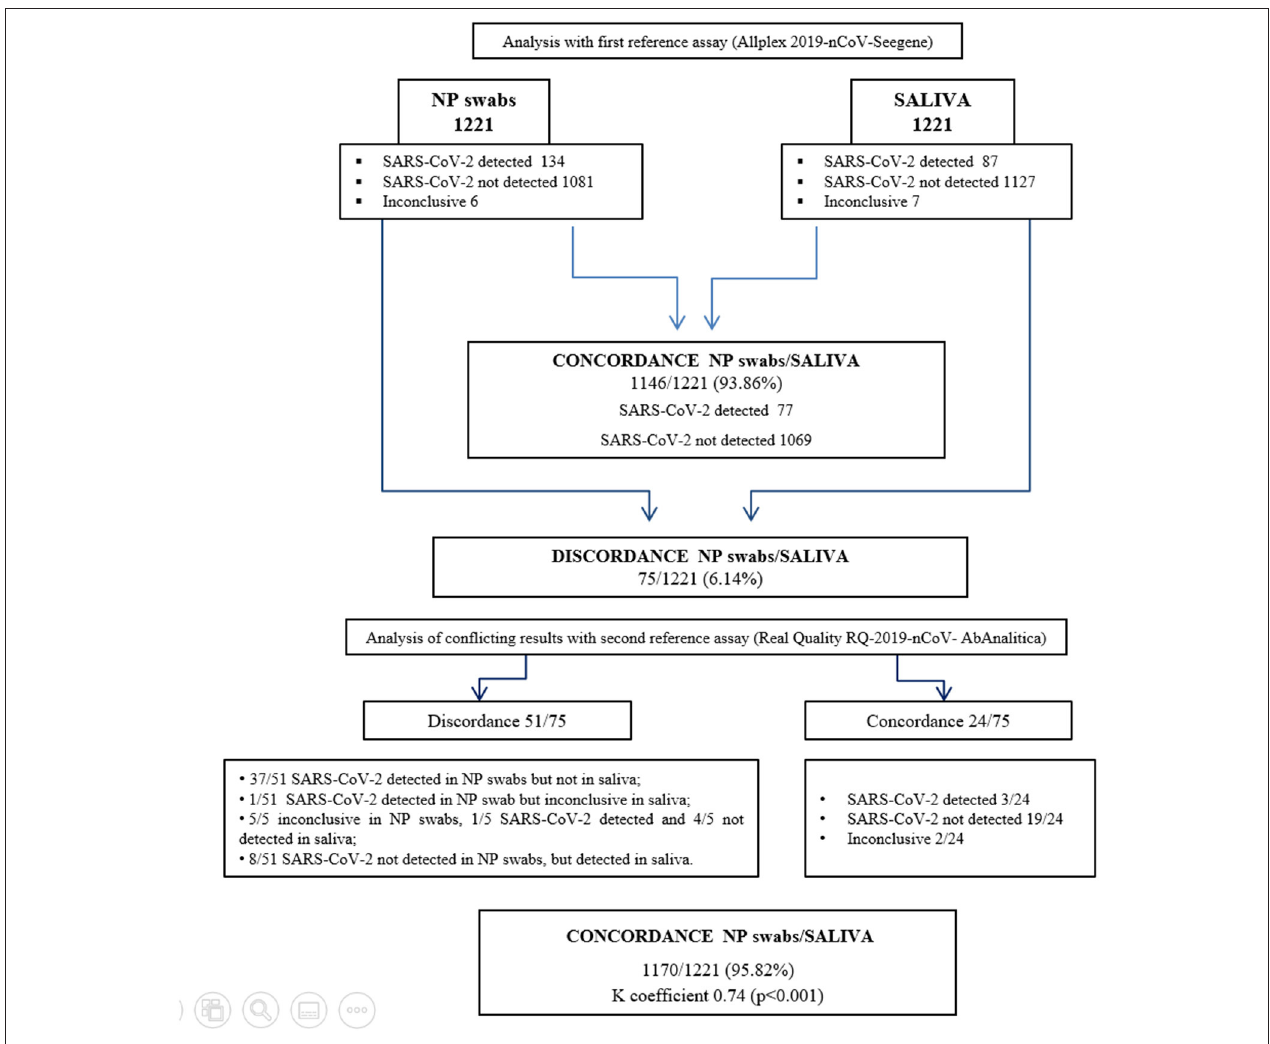
FIGURE 1 | Analytical workflow of the